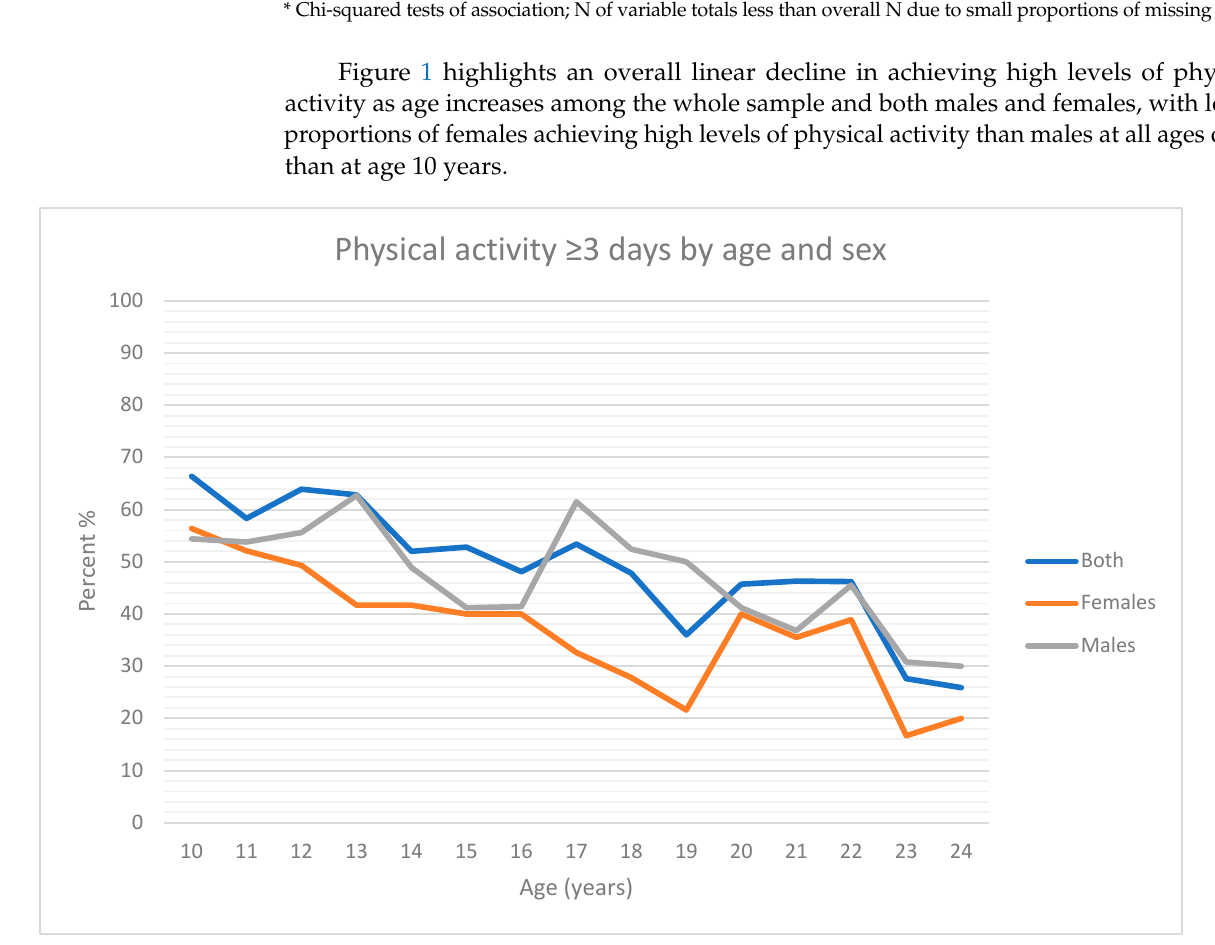
Figure 1. Percent of Next Generation Youth Well-being Study participants achieving ≥ 3 days a week of physical activity by age.